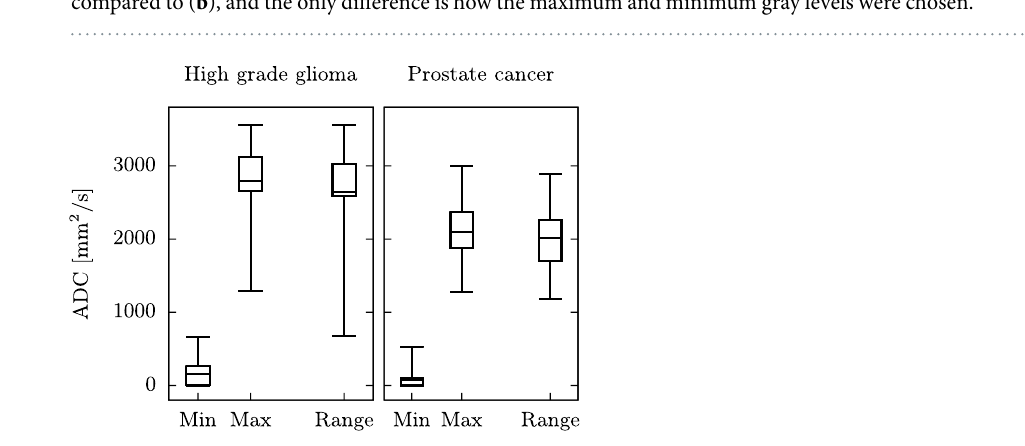
Figure 5. The effect of using different minimum and maximum values when quantizing the image. The images show how different minimum and maximum values influence the result when quantizing the original image, prior to constructing the GLCM. ( a ) Shows the original image with 4096 gray levels. In ( b ) the image has been quantized to 8 gray levels, and the minimum and maximum gray levels have been set to that of the ROI, dashed outline. In ( c ), the image has been quantized to 8 gray levels and minimum and maximum gray levels have been set based on the entire image. There are large regions of uniform gray levels in ( c ), the texture is very different compared to ( b ), and the only difference is how the maximum and minimum gray levels were chosen.